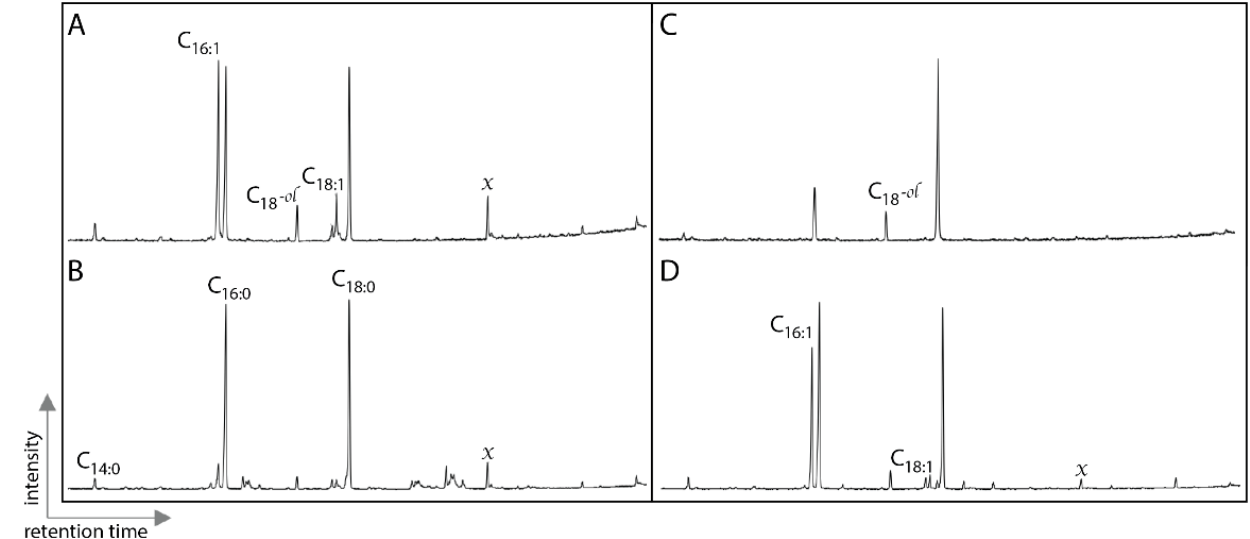
Figure 3. Partial total ion chromatograms of silyated total lipid extracts from Ghost Ranch Hayden Quarry 4: ( A ) fossil bone and ( B ) associated matrix. Hayden Quarry 2 ( C ) fossil bone and ( D associ- ated matrix. Tetradecanoic acid (C14:0), hexadecanoic acid (C16:0, C16:1), octadecanoic acid (C18:0, C18:1, octadecan-1-ol (C18:0 -ol ) and contaminants (x).